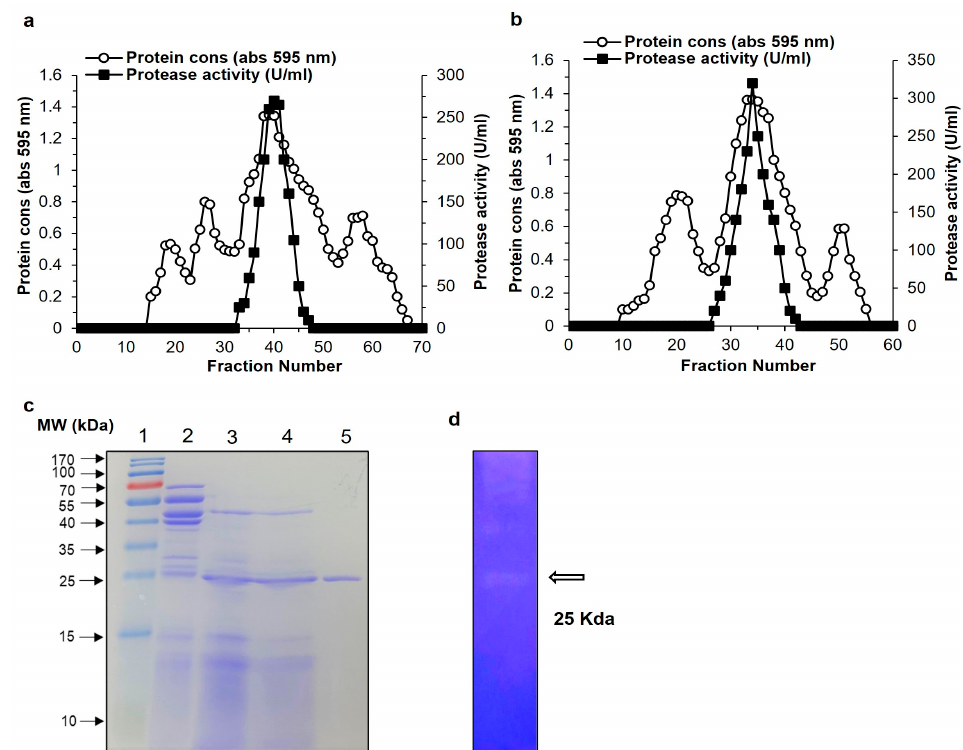
Figure 2. Purification of protease SH21 from Bacillus siamensis strain CSB55. Chromatography profile of SH21 on gel filtration using ( a ) Sepharose CL-6B (80 cm × 1.8 cm) and ( b ) Sephadex G-75 column (1.5 × 20 cm). ( c ) SDS-PAGE (12%) of purified protease SH21. Lane 1, protein molecular weight marker standard from 10 to 170 kDa. Lane 2, crude extract. Lane 3, ammonium sulfate precipitation (40–80%). Lane 4, sample after Sepharose CL-6B chromatography. Lane 5, purified protease SH21 after Sephadex G-75 column. ( d ) Zymography of purified SH21.